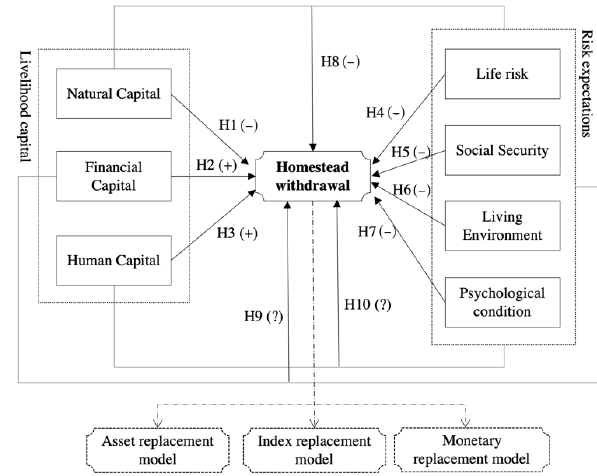
Figure 1. Theoretical framework and research